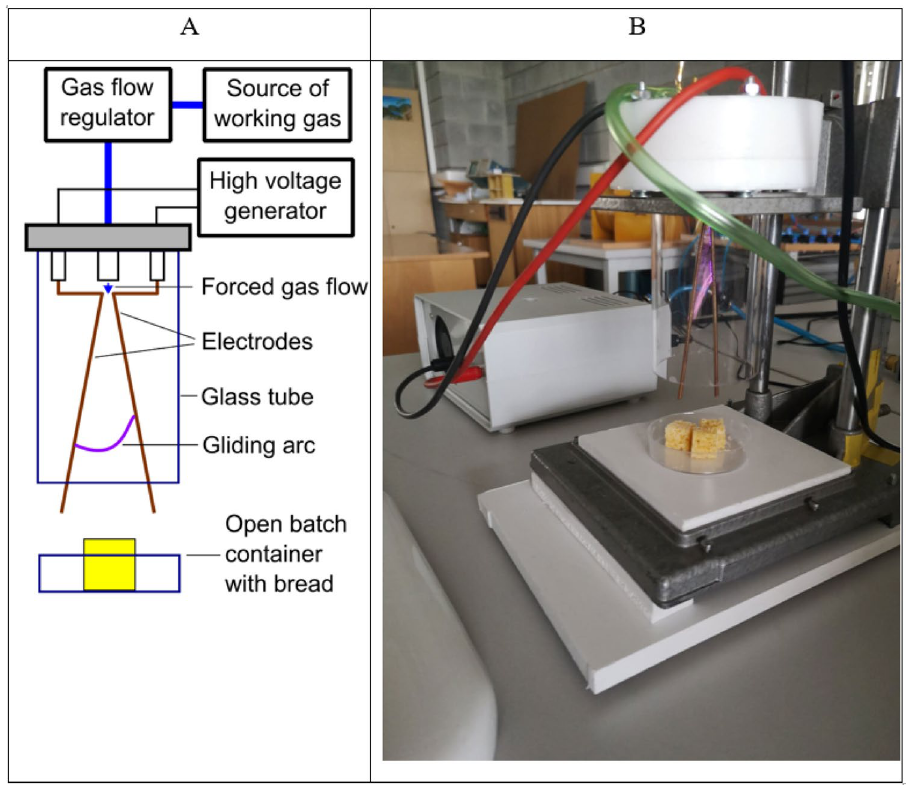
Figure 1. Experimental set-up ( A scheme, B